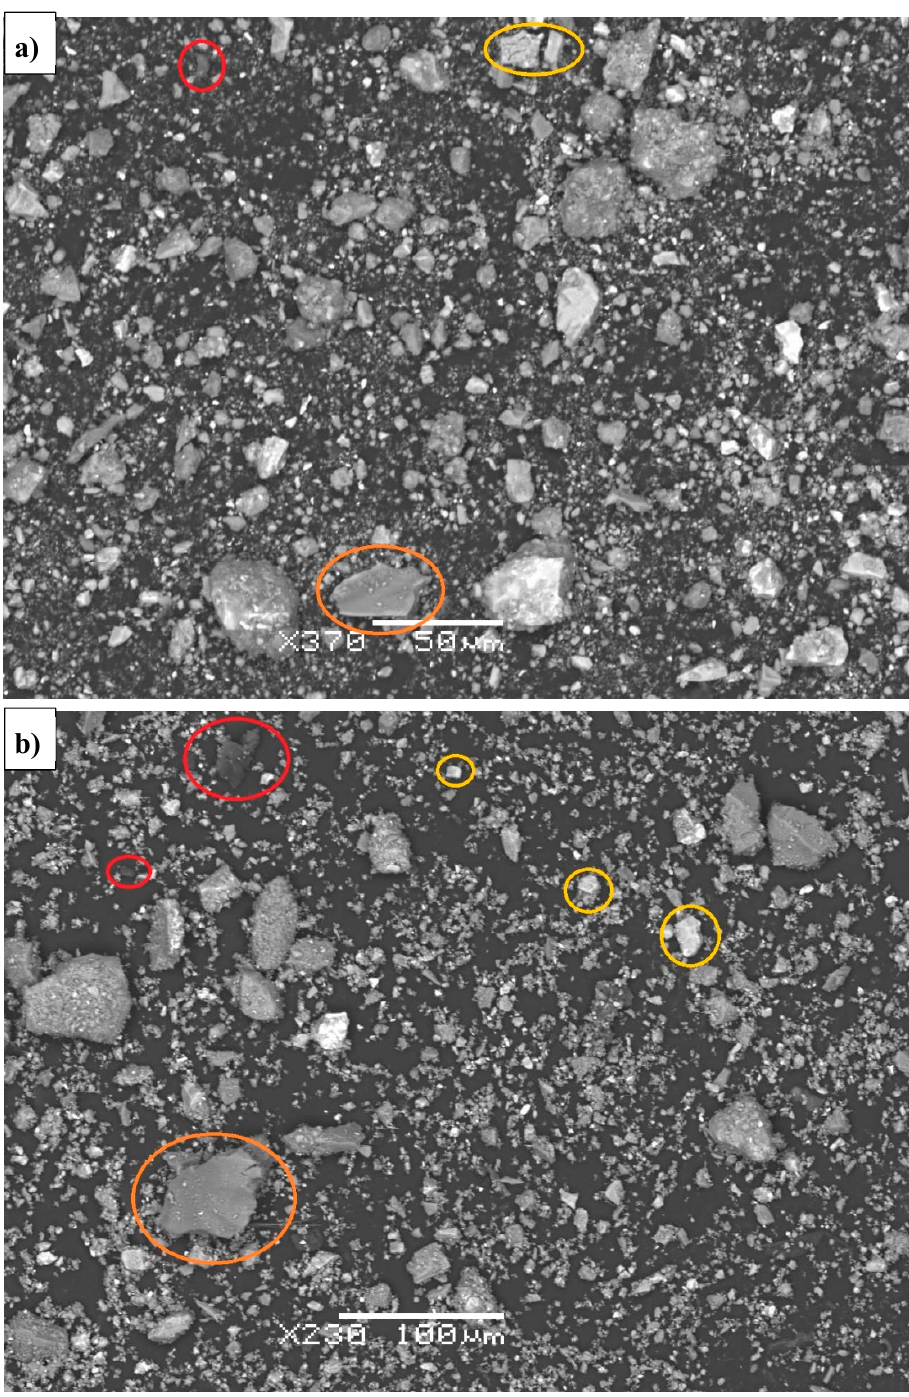
Figure 10. SEM scan of Slag A ( a ) and Slag R ( b ).